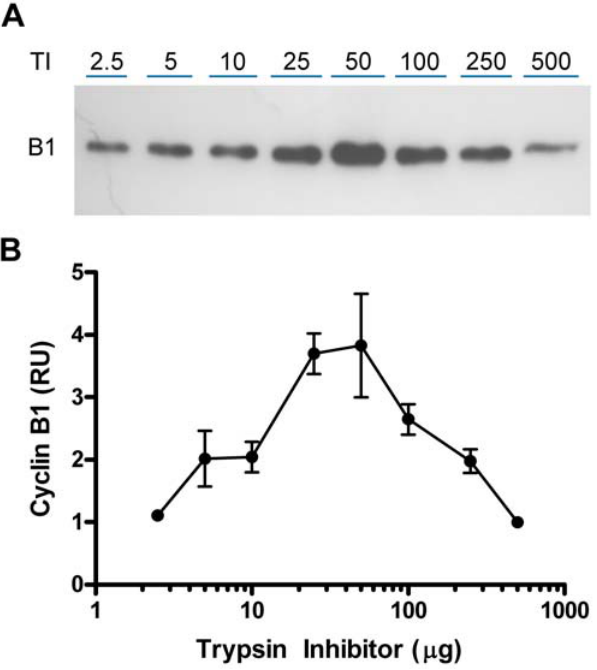
Figure 1. Protein level affects epitope detection. ( A ) A fixed amount of purified cyclin B1 (6.36 ng) was added to a serial dilution of trypsin inhibitor (TI) and subjected to electrophoresis and Western blotting. ( B ) Relative intensity of the cyclin B1 bands is presented corresponding to trypsin inhibitor levels. Cyclin B1 intensity was maximal at 25–50 m g trypsin inhibitor and decreased at lower and higher protein levels. Densitometry readings from 3 experiments and 6 gels were combined by normalizing by linear regression on measure- ments common to each paired series. The number of common points ranged from 6 to 8. The combined set was then normalized to the 500 TI mean value, therefore the Y axis can be read as fold over this value.